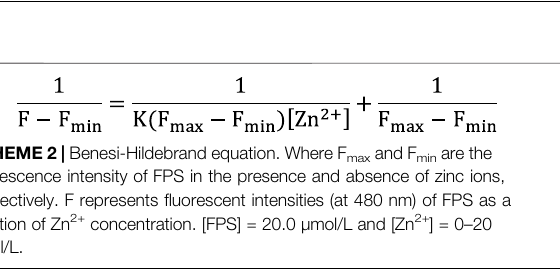
FIGURE 8 | CLSM images of Hela cells treated under various conditions: (A) Hela cells were incubated with culture medium as a control; (B) Hela cells were cultured with probe FPS solution (5.0 μ mol/L) for 25 min; (C) Hela cells were cultured with probe FPS solution (5.0 μ mol/L) for 25 min, and after being washed with PBS and further incubated with Zn 2+ (10.0 μ mol/L) were then incubated for 5 min.